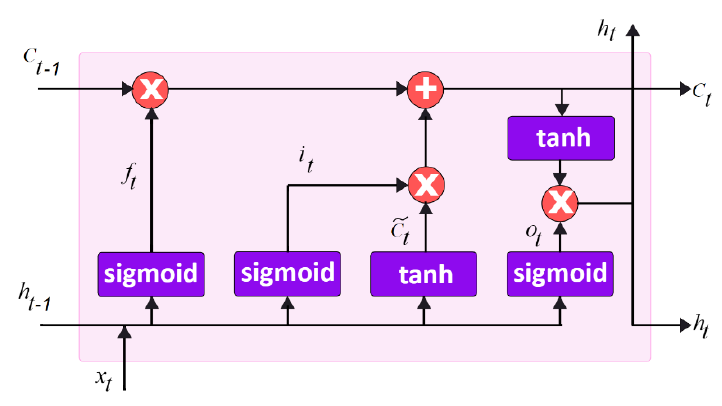
Figure 3. Generic LSTM model.